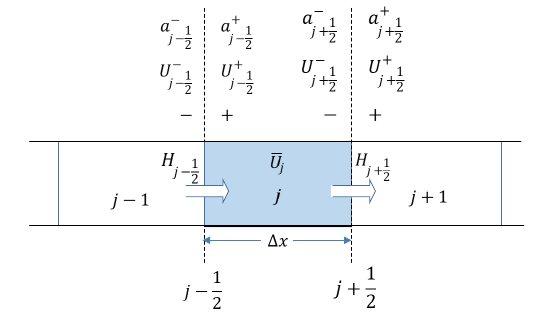
Figure 3: A Control Volume of the KP scheme where the local speed of wave propagations a ± be calculated as the largest and smallest eigenvalues of the Jacobian of the